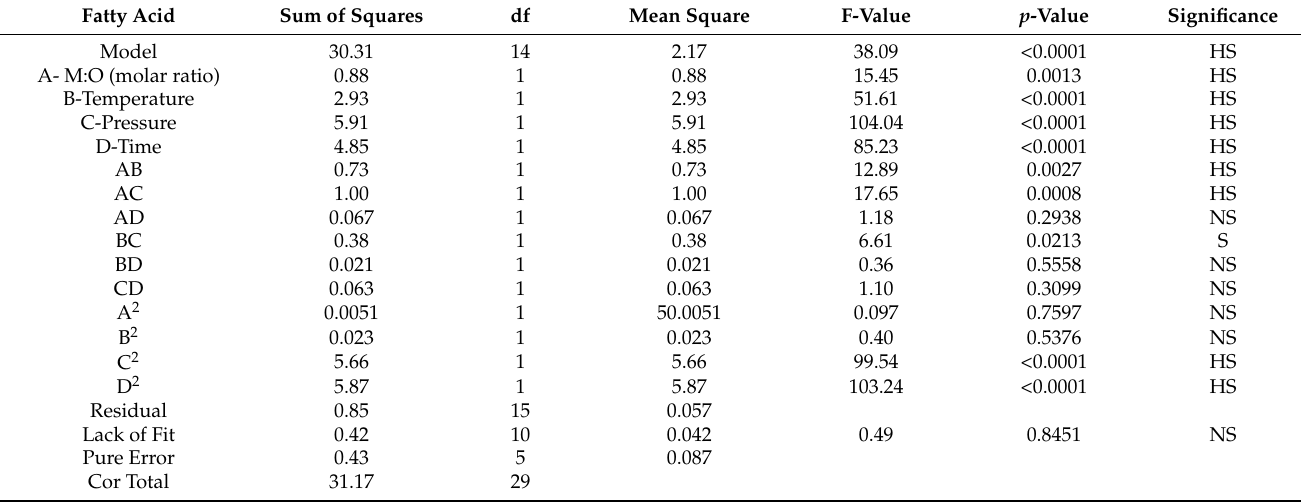
Table A4. Analysis of variance for FAME yield of methyl-myristate